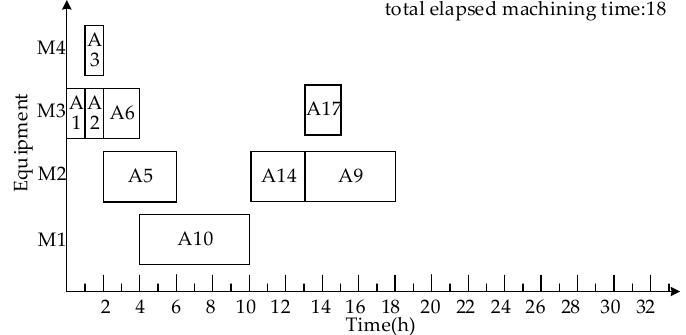
Figure 5. Gantt chart of P 62 .